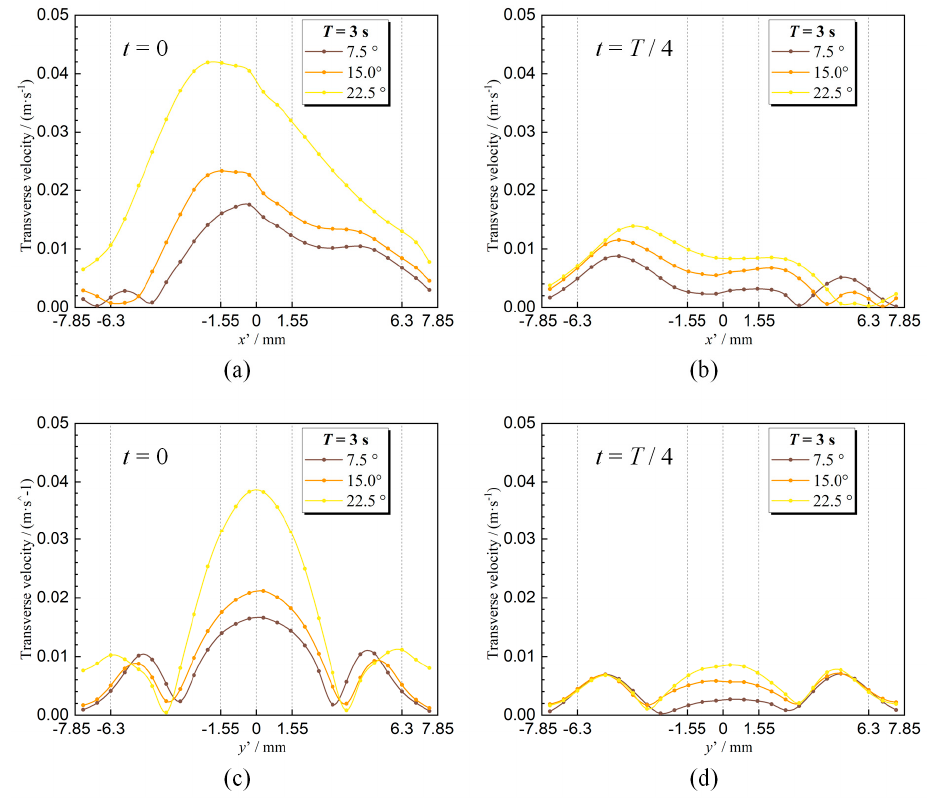
Figure 9. Effect of the amplitude on the transverse velocity. Transverse velocity on the x (cid:48) -axis at ( a ) t = 0 and ( b ) t = T /4; ( c ) transverse velocity on the y (cid:48) -axis at ( c ) t = 0 and ( d ) t = T /4. The transverse velocity in the middle of the cross-section is in the positive direction of the x (cid:48) -axis when the subchannel is in the equilibrium position ( t = 0). On the negative side of the x (cid:48) -axis, the transverse flow is in the negative x (cid:48) -axis direction. For the small amplitude (7.5 ◦ ), the transverse velocity induced by rolling motion is small, and the